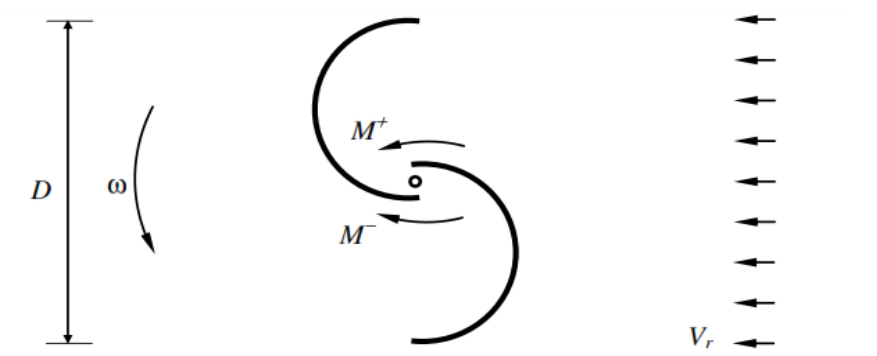
Figure 3 – The direction of torque affecting the rotor blades using wind power Рис . 3 – Направление крутящего момента , воздействуещего на лопасти